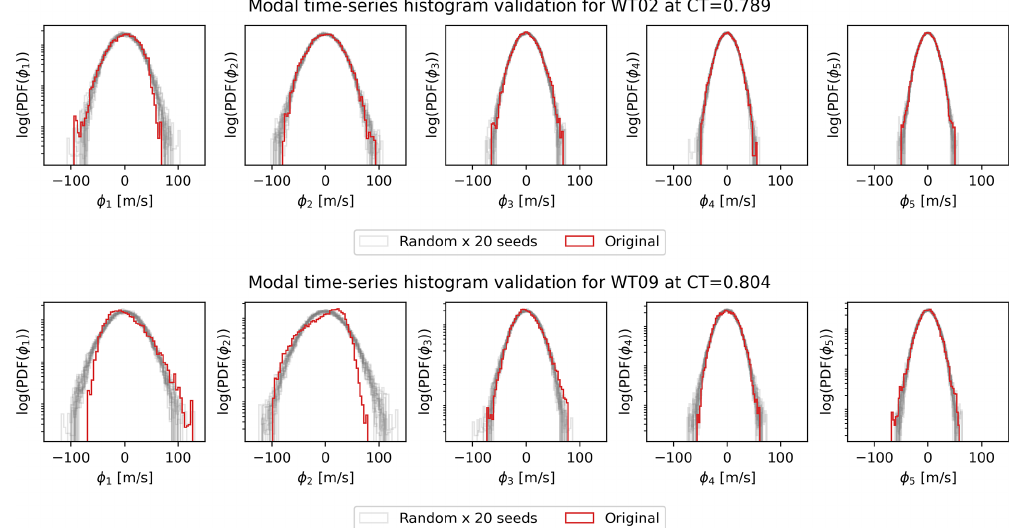
Figure 11. Comparison of modal time series histograms for original and random-realization-evaluated high C T (a member of the training dataset) for WT02 and